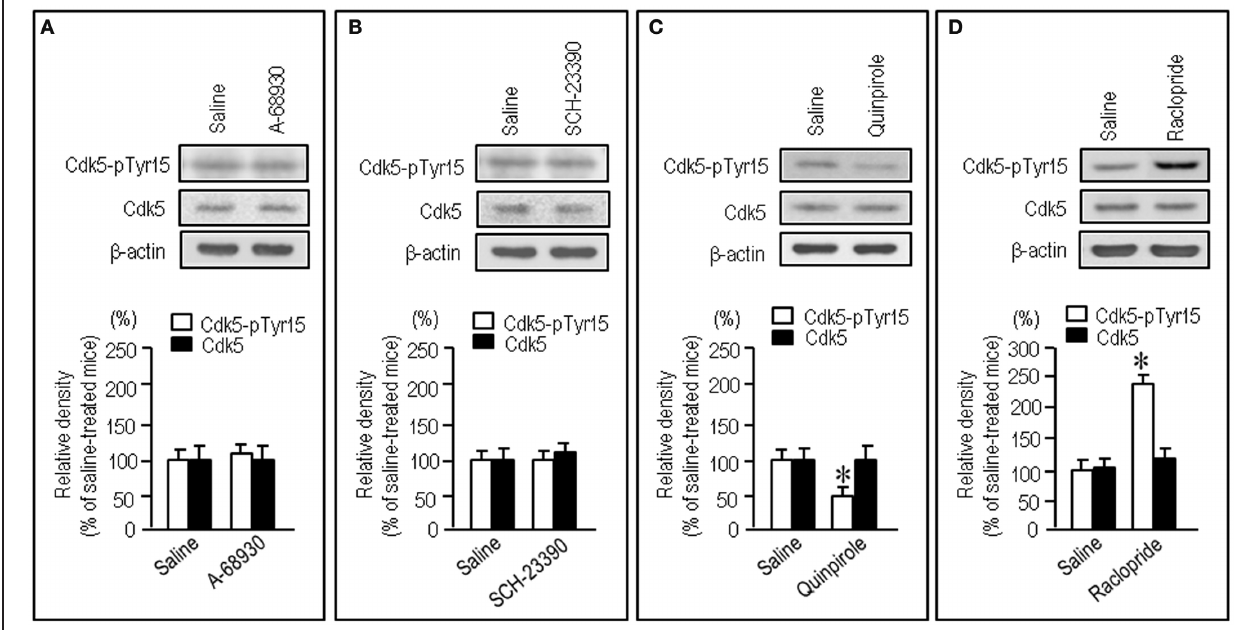
before sacrifice. Effects of administration of A-68930 (A) , SCH-23390 (B) , quinpirole (C) , or raclopride (D), on striatal levels of Cdk5-pTyr15 are shown. Values are means ± S.E.M. ( n = 5). ∗ P < 0 . 005 versus saline-treated mice; two tailed Student’s t